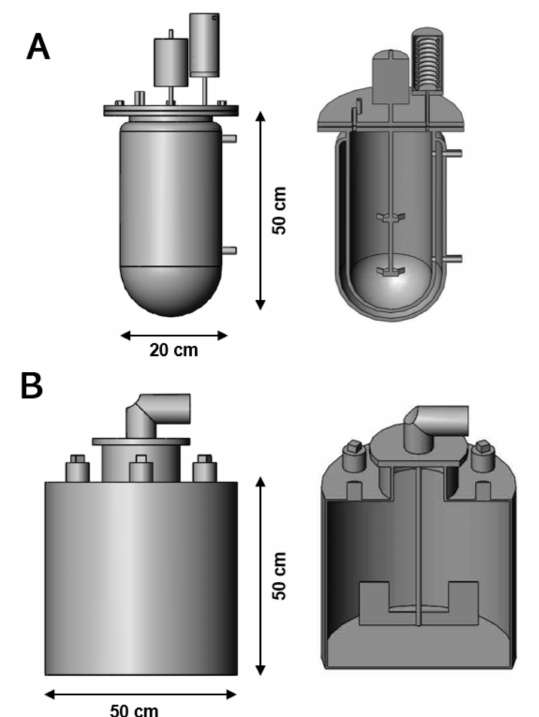
Figure 1. Schematic view of the 7.5 L ( A ) and 100 L ( B ) stirred-tank bioreactors used to perform the fermentation scale-up experiments. The optimal operating conditions determined during the CCD-RSM were utilised to maximise the production of ethanol from non-treated sugar beet